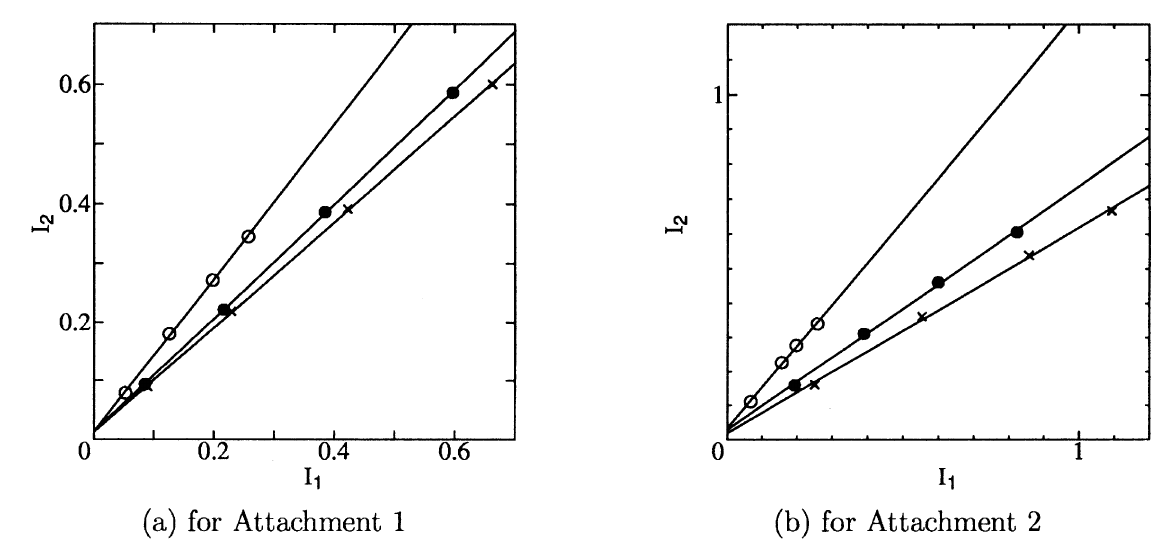
◦ • = sponge rubber; = plastic foam; × = vulcanized